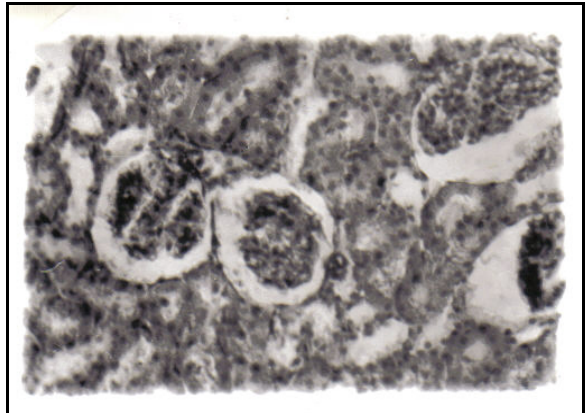
Figure 1. Photomicrographs of H&E stained sections of rat kidney ( Magnification X250 ).